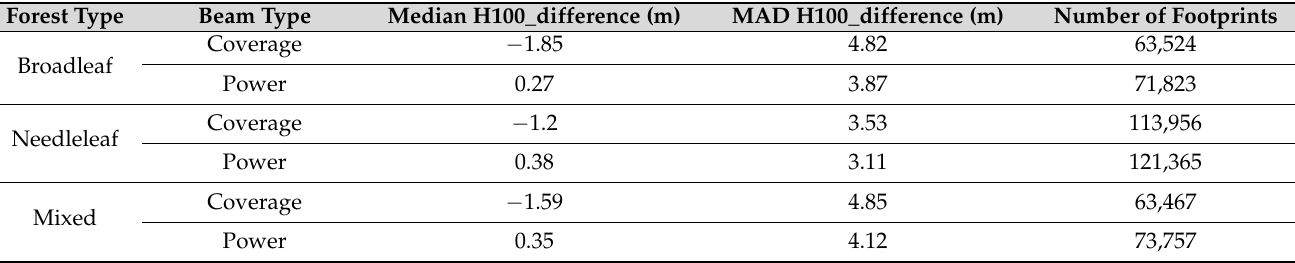
Figure 12. Boxplot of H_difference on beam type for ( a ) broadleaf, ( b ) needleleaf, and ( c ) mixed forest. Table 3. Statistics of H100_difference for two groups of datasets based on beam type in three forest types.